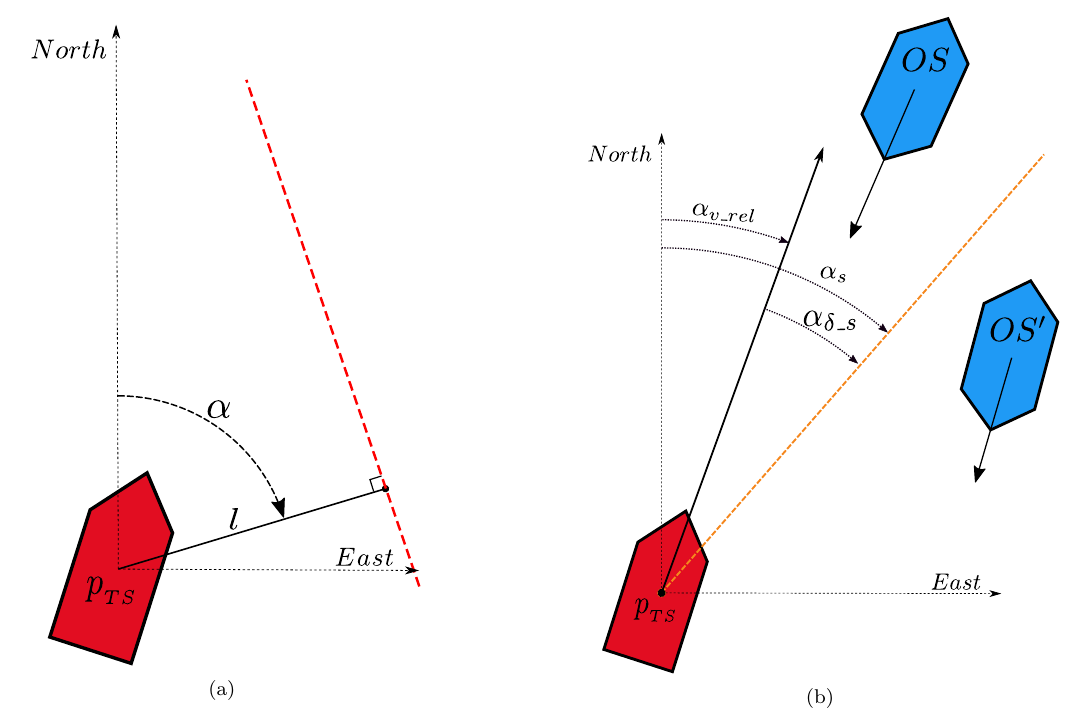
Figure 5: TS domain: a) TS domain defined by the angle α and the distance l > 0. b) Two instances of the OS on either side of the port-starboard split